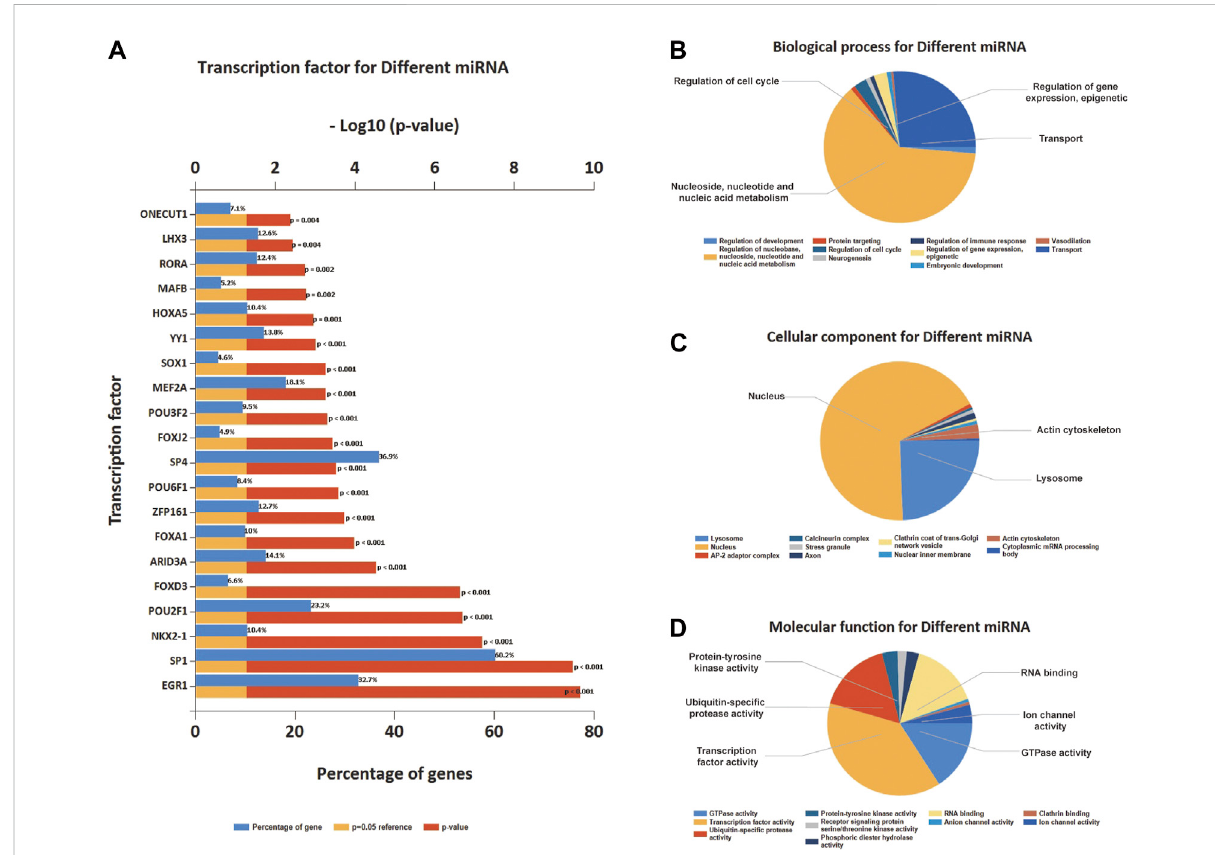
FIGURE 5 Transcriptionfactors(TFs)enrichmentandGOenrichmentanalysisofdifferentialexpressionofmiRNA. (A) Thetop20 TFswereenrichedbased on differential expression of miRNA. (B) BP enrichment of the top 10 on differential expression of miRNA. (C) CC enrichment of the top 10 on differential expression of miRNA. (D) MF enrichment of the top 10 on differential expression of miRNA.